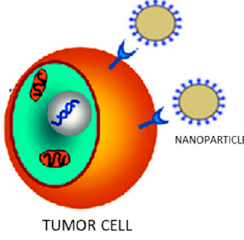
Figure 2. Receptor interaction between drug-containing nanoparticles and tumor cell.